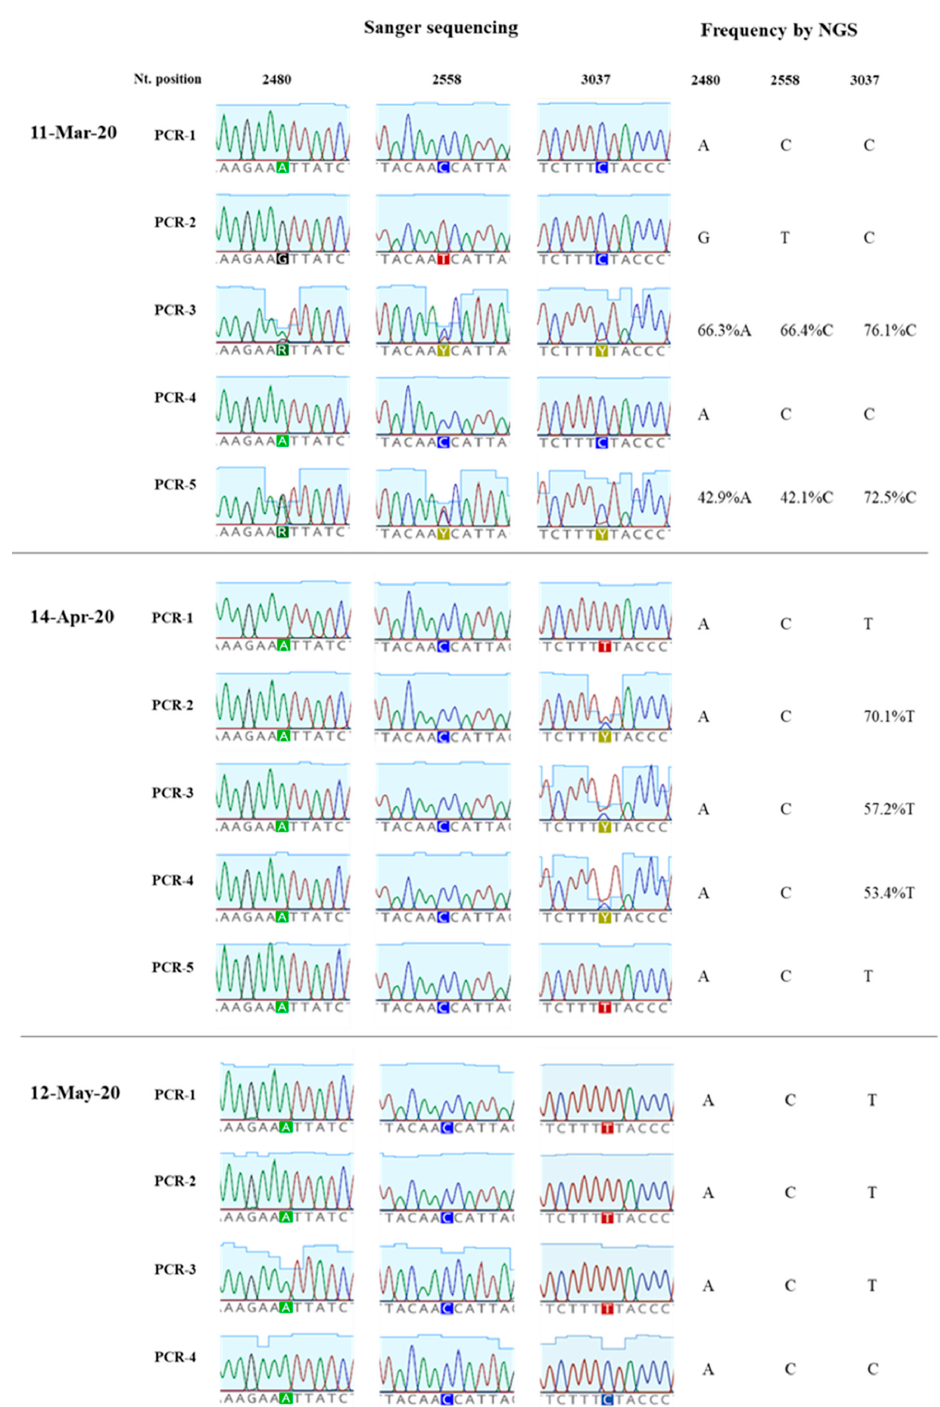
Figure 4. Nucleotide sequence variation in SARS-CoV-2 nPCR1 products from wastewater concentrates. The results of Sanger and NGS analysis of selected nPCR1 products obtained from RNA samples extracted from wastewater concentrates collected on 11th March, 14th April and 12th May are shown.